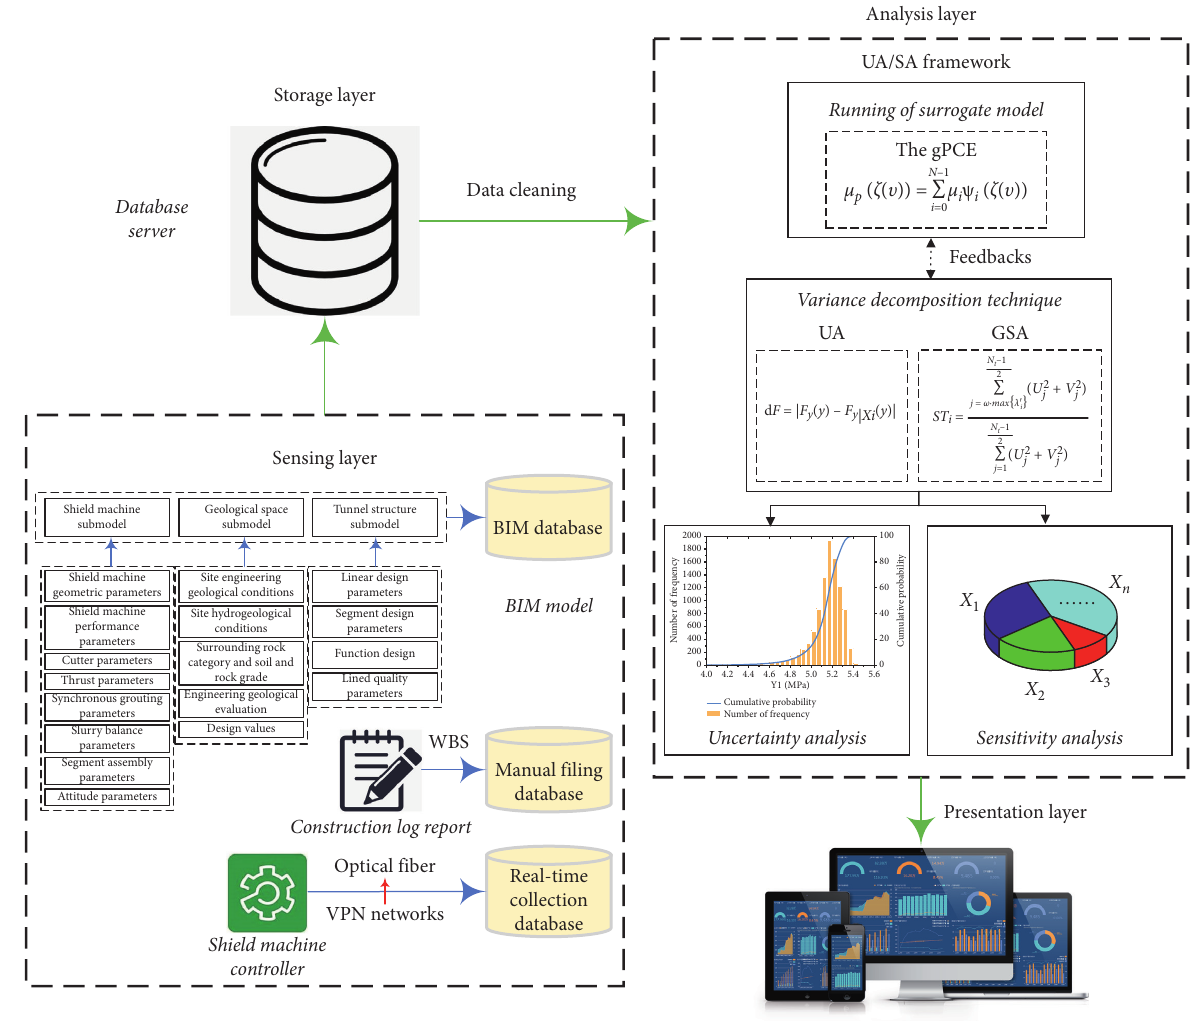
Figure 1: The architecture of the